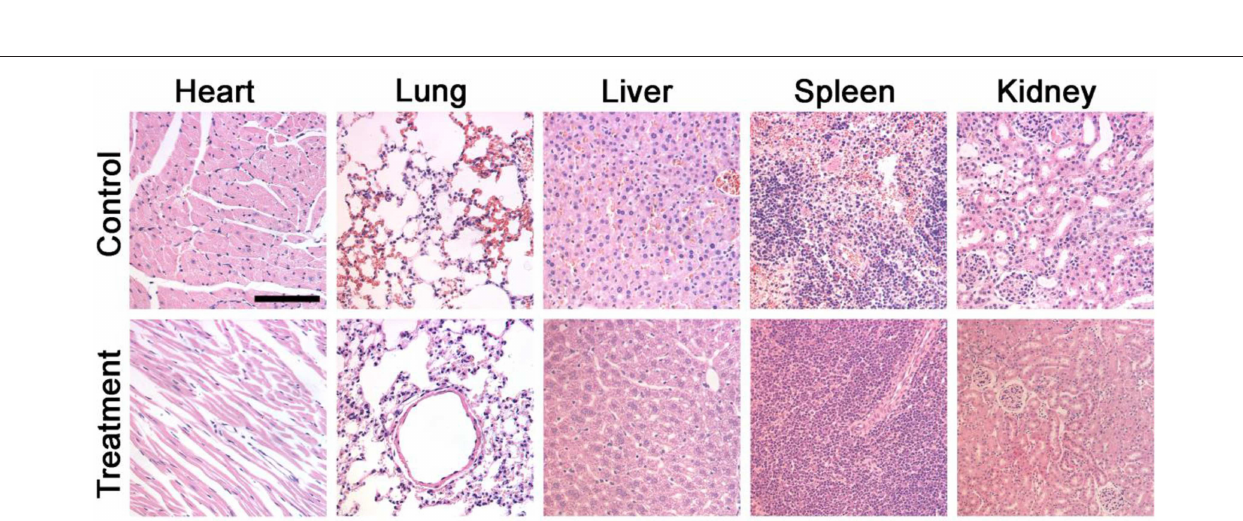
Frontiers in Materials |